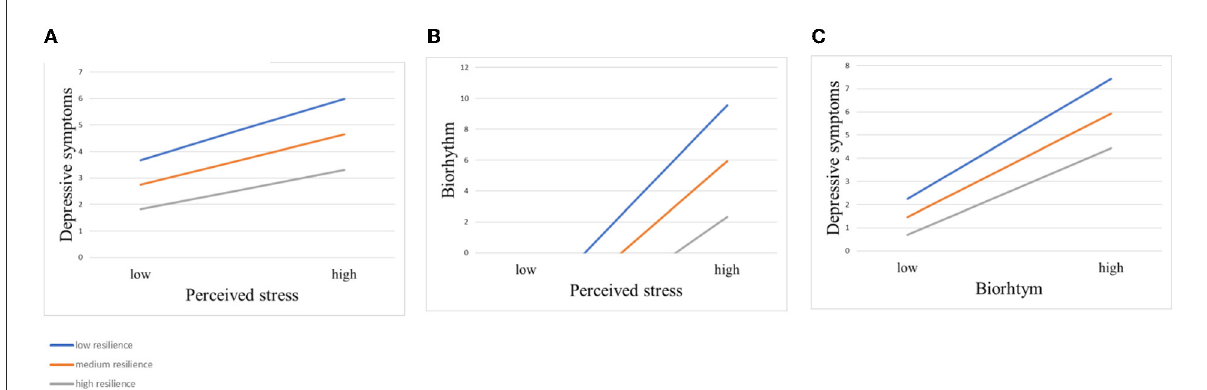
FIGURE3 Moderating effects of different levels of resilience on the relationship between perceived stress and depressive symptoms. (A) Moderating effect of different levels of resilience on perceived stress and depressive symptoms. (B) Moderating effect of different levels of resilience on perceived stress and biorhythm. (C) Moderating effect of different levels of resilience on biorhythm and depressive symptoms.